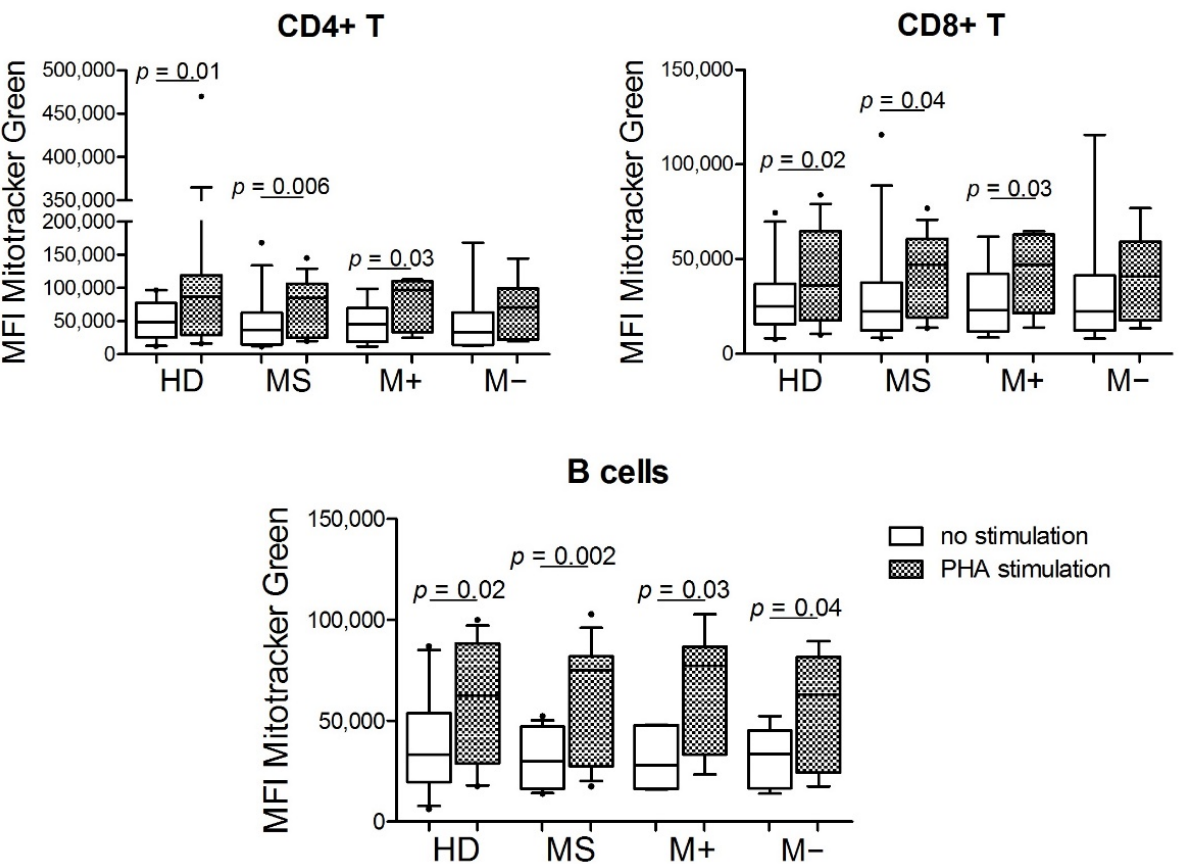
Figure 1. Mitochondrial mass of cell subsets from peripheral blood of multiple sclerosis (MS) patients and healthy donors (HD).